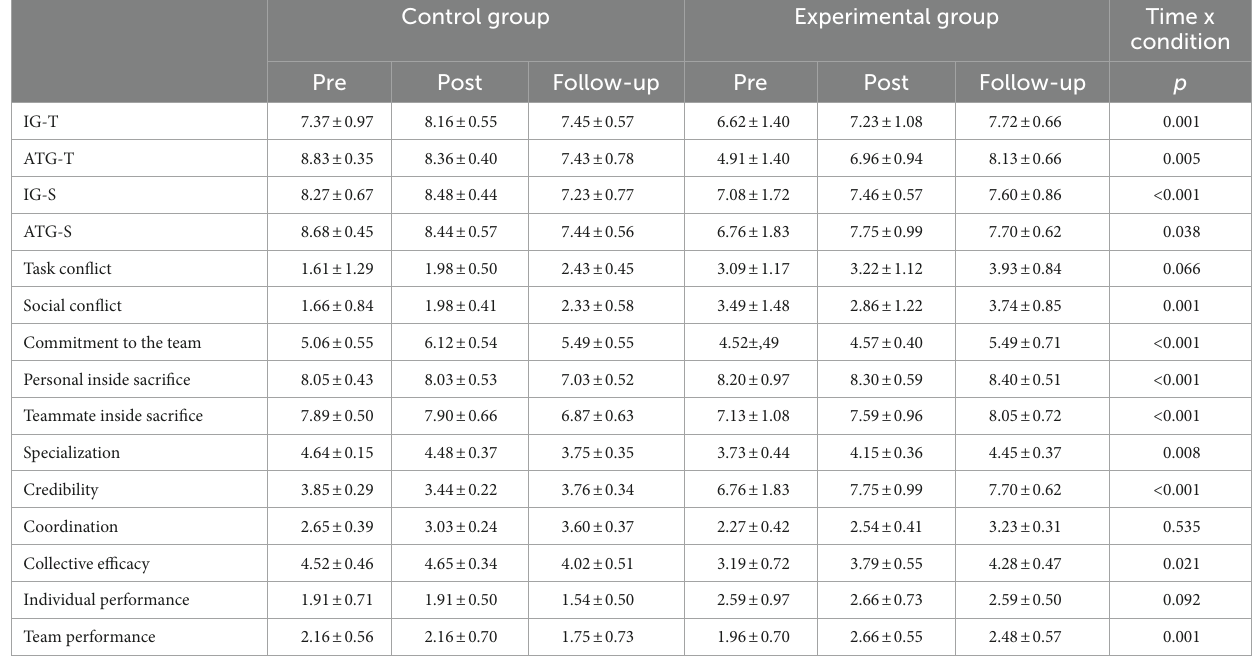
TABLE 4 Results of mixed repeated-measures ANOVA in variables related to outputs – team